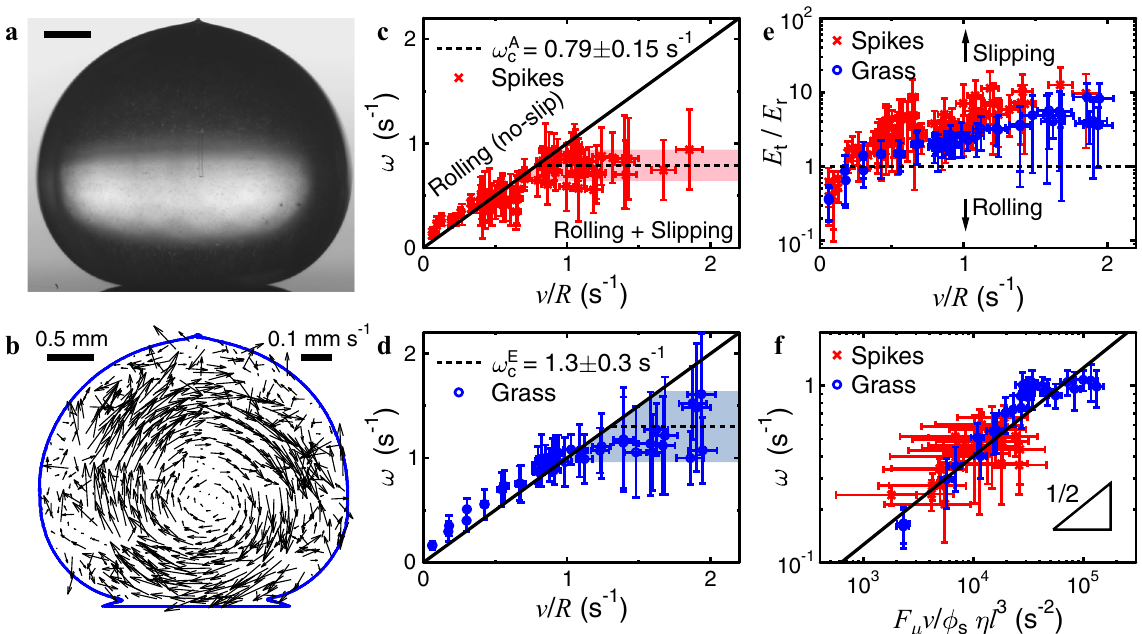
Fig. 5 Rolling vs. slipping droplets. a , b Particle image velocimetry experiments showing the rolling fl ow inside a water droplet ( R ¼ 1658 ± 8 μ m, substrate speed v ¼ 0 : 1 mm s − 1 to the left) on the spikes (A) surface. Scale bar in a 0.5 mm. The blue line in b shows the outline of the droplet. c, d Angular droplet velocity as a function of the ratio between sample speed and droplet radius ( v = R , v ¼ 0 : 1 to 1.9 mm s − 1 and R ¼ 0 : 8 to 1.6 mm) for the spikes (A) and grass (E) samples, respectively. Slowly rotating droplets behave as solid spheres rolling without any slippage ( ω ¼ v = R , solid line with a slope of unity). As v = R exceeds a critical value ( ω c , dashed line), ω remains constant and the rolling droplet starts slipping as v = R is further increased. e The ratio between translational and rotational kinetic energy ( E t = E r ¼ 5 ð v = R Þ 2 = 2 ω 2 ) as a function of v = R on the spikes (A) and grass (E) samples. f The angular velocity data for sliplessly rolling droplets ( v = R < ω c ) on the spikes (A) and grass (E) samples collapse when plotted as a function of F μ v = ηϕ log – log plot has a slope of ½ as predicted by Eq. (2). The error bars in all graphs are standard deviations or error propagations including these